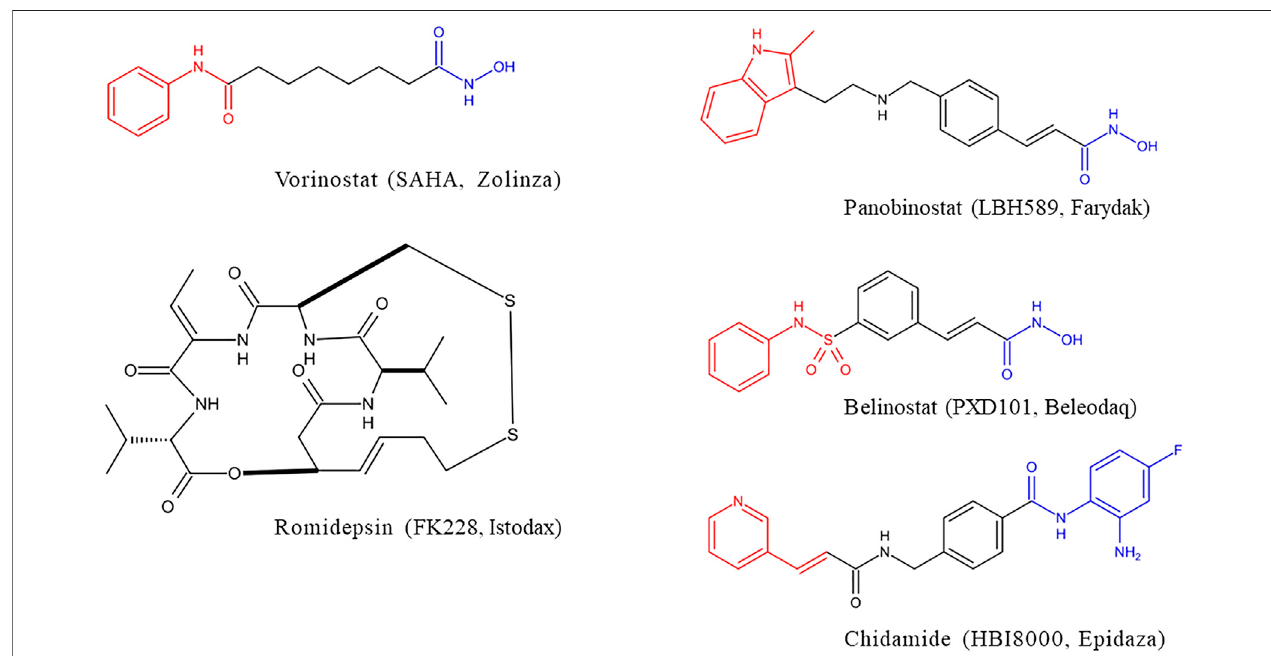
FIGURE 3 | Structure of HDACs inhibitors